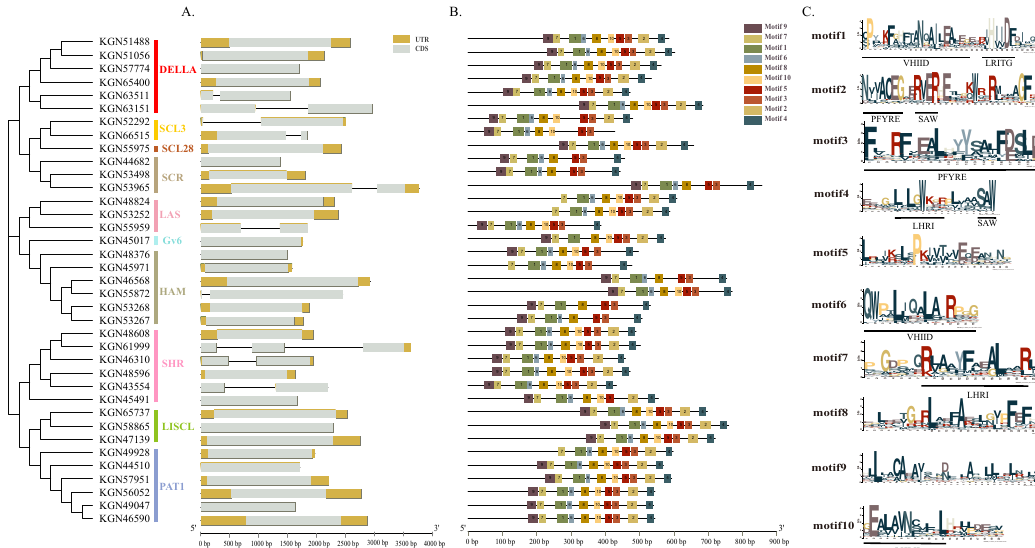
Figure 2. Structural analysis of CsaGRAS genes in cucumber. ( A ) The exon-intron structure of GRAS gene. ( B ) The distribution of motif in GRAS proteins. ( C ) The amino acid composition of each